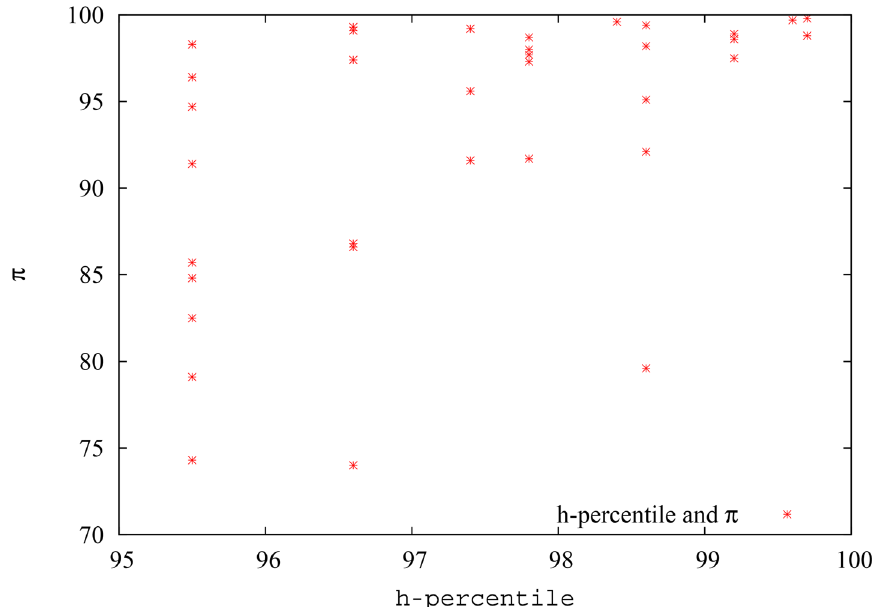
Fig 18. The h-index and pagerank-index of the best 5% authors (according to h-index) in the field of quantum game theory. Since the pagerank-index is a percentile, percentile values were used for the h-index as well, rather than actual h-index values. Note here that the pagerank-index value varies from 70% to 100%. That is, some authors who are among the top 5% in terms of h-index are not even among the top 25% when pagerank-index is